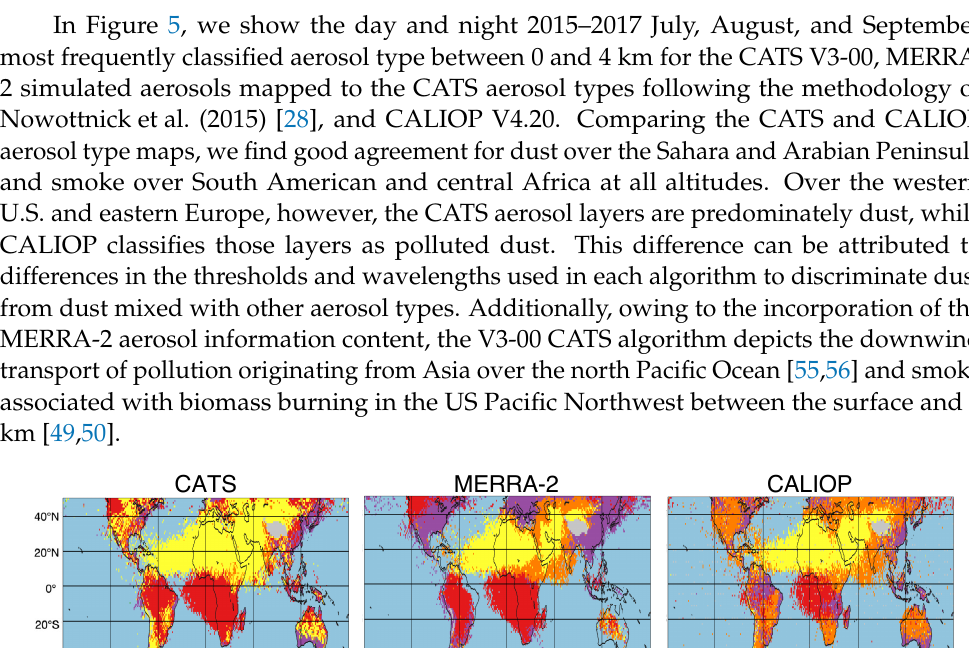
Figure 4. Seasonality of the CATS V3-00 most frequently classified aerosol type below 4 km for 2015–2017.